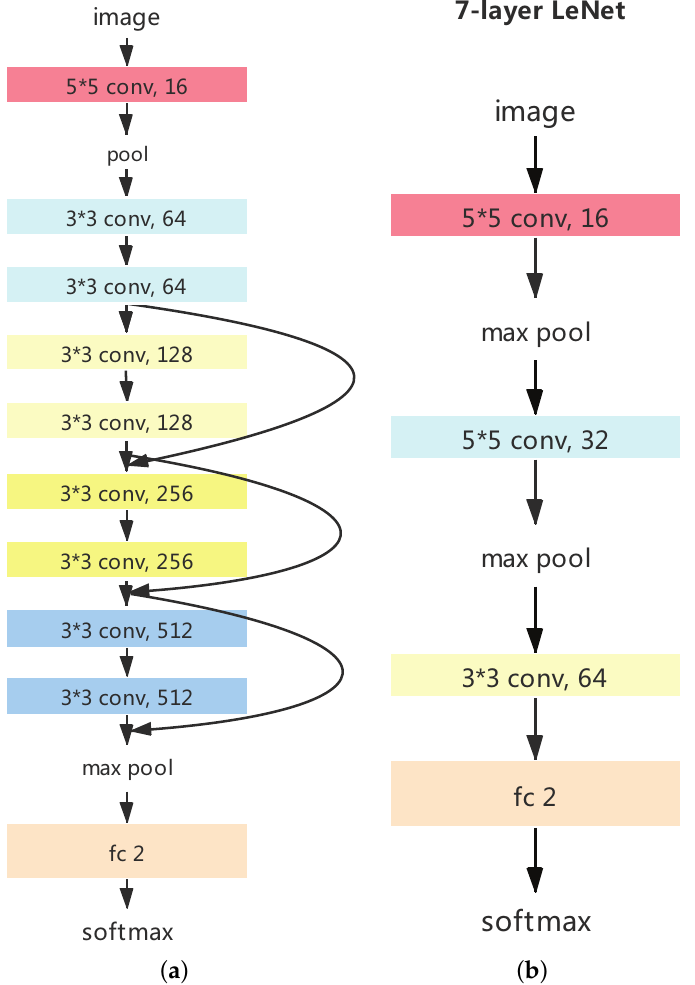
Figure 3. Network structure. ( a ) The structure of Scene classification network. ( b ) The structure of Target detection